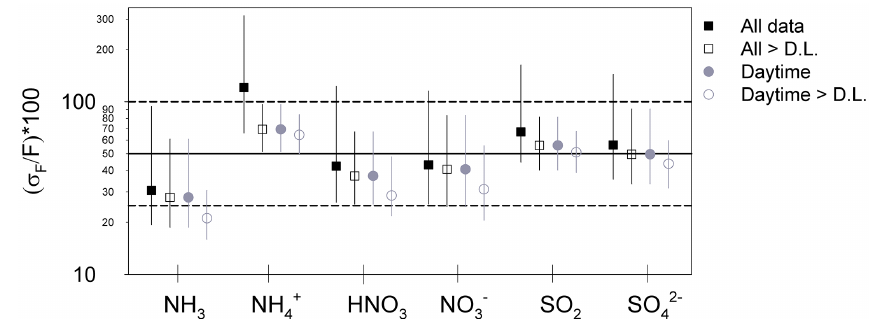
Figure 2. Summary of flux error (Eq. 4) expressed as a median percentage of the flux magnitude. Data are summarized as all data, all fluxes in which the chemical gradient exceeds the gradient detection limit, all daytime data and daytime data in which the chemical gradient exceeds the gradient detection limit. Error bars represent interquartile